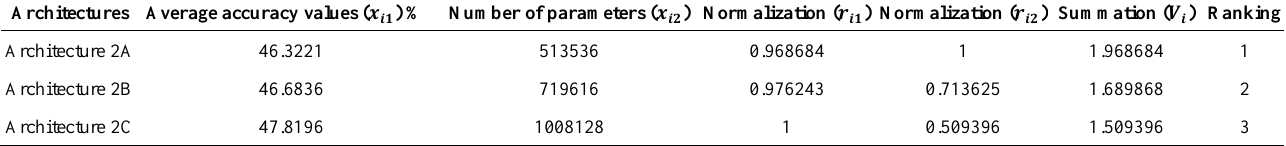
Table 7. Normalization results for the second stage of the AMIGOS dataset